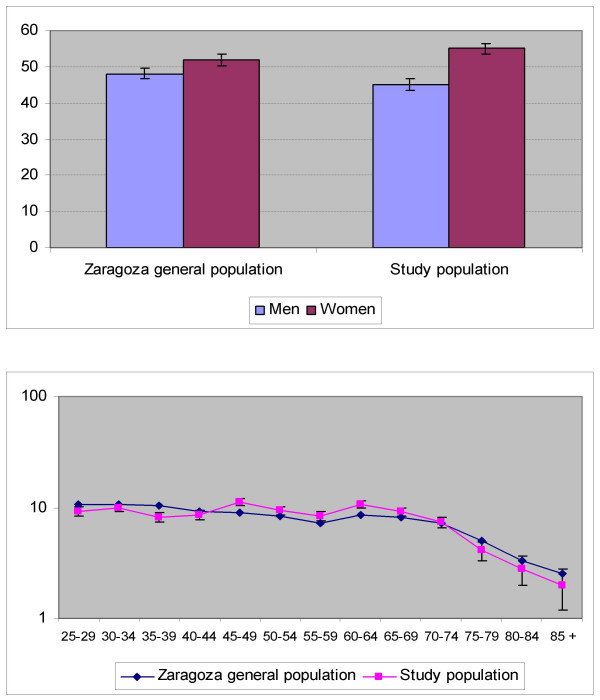
Age and gender distribution of the study population and of the Zaragoza general population.